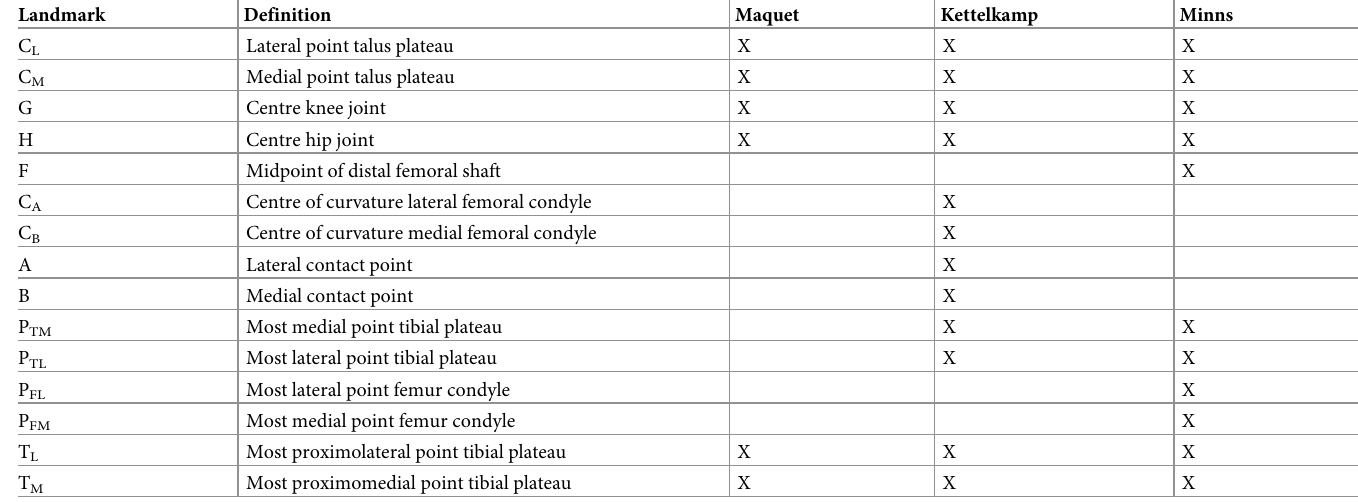
Table 3. Landmark template for the calculation of model-specific input parameters. The circle tool was used for H, C A and C B and the point tool for all other landmarks. Landmark